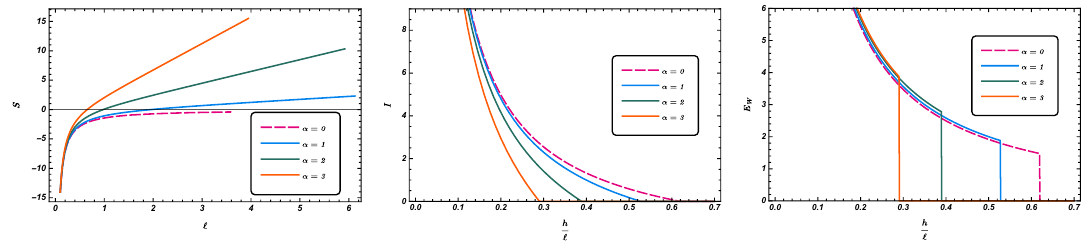
Figure 7 . The HEE (left), HMI (middle) and EoP (right) as a function of h and ‘ for different values of the momentum relaxation parameter. Here we have set d = 3 and m = 0